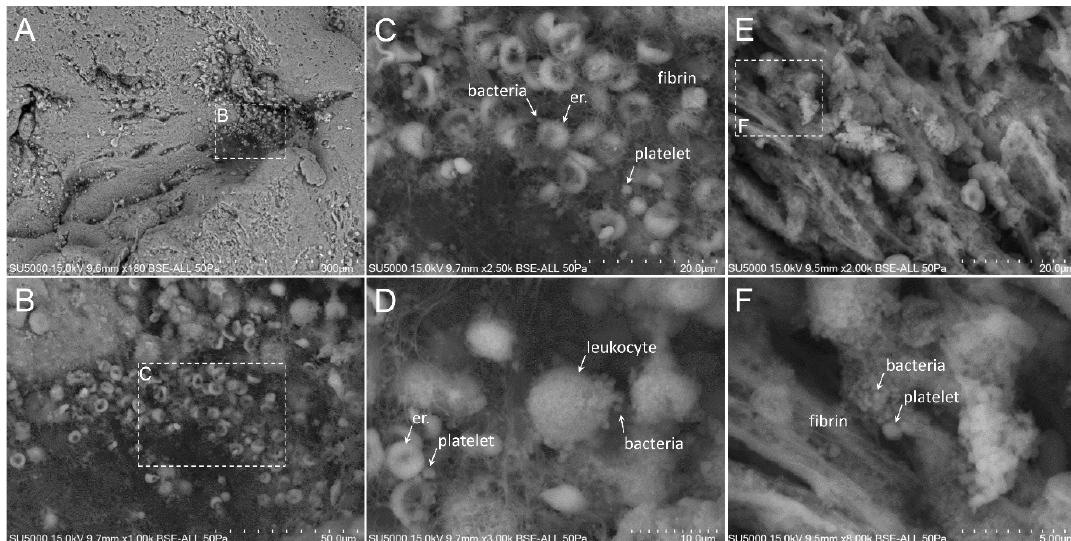
Figure 3. Scanning electron microscopy of S. agalctiae -infected vegetation. ( A , B ) Low magnification of the vegetation showing the presence of a high number of erythrocytes. ( C ) Erythrocytes, platelets and bacteria enwrapped in a thin fibrin network. ( D ) Leukocytes lined by bacteria. ( E ) Thick fibrin bundles with aggregates of platelets and clustered bacteria. ( F ) Zoom-in on the boxed region in ( E ).